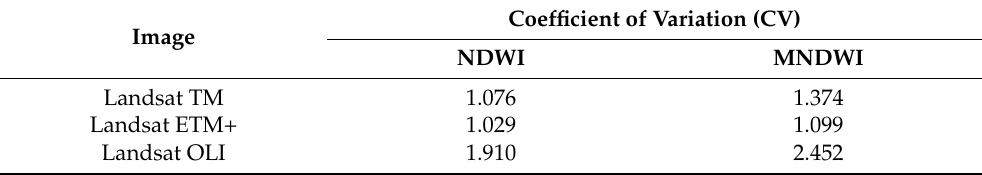
Table 2. Coefficient of variation (CV) of water index.